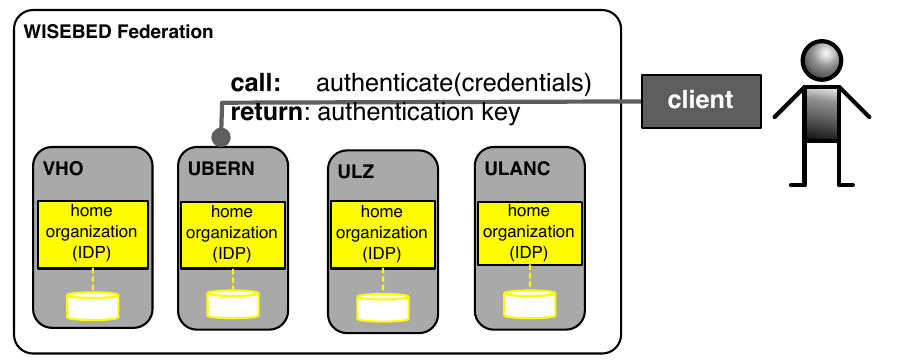
Figure 5. Message Flow: